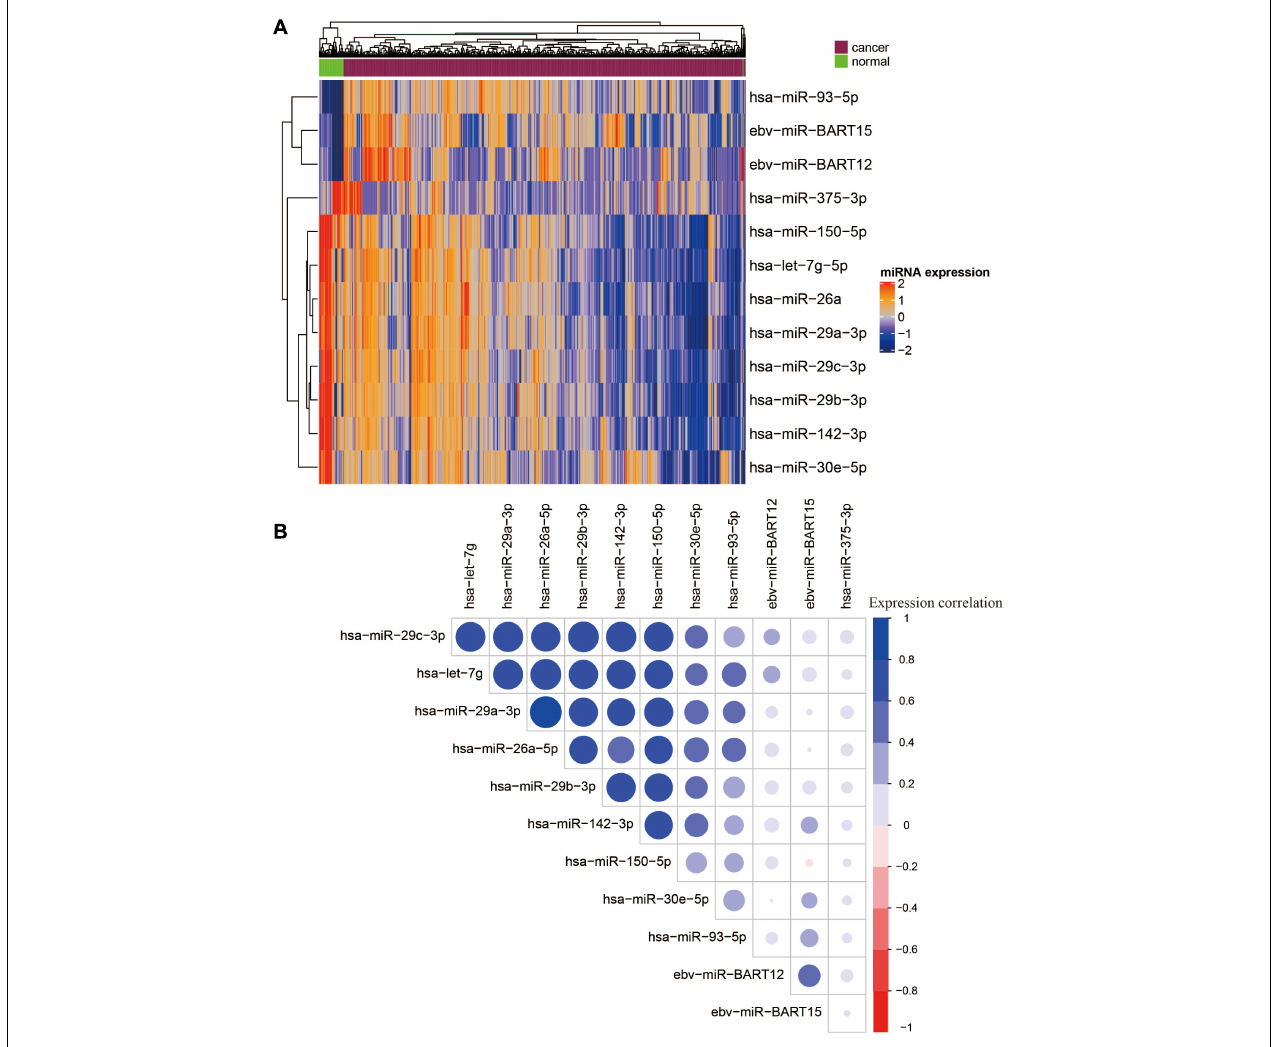
FIGURE 2 | Heatmap and correlation matrix of 12 OS-related DE miRNAs. (A) Heatmap of 12 overall survival and differentially expressed miRNAs. (B) Correlation matrix of 12 OS-related DE